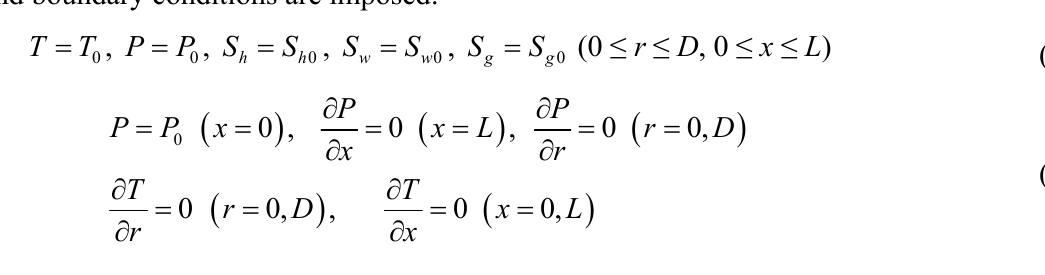
Figure 1. Schematic of the computational grid of hydrate dissociation.